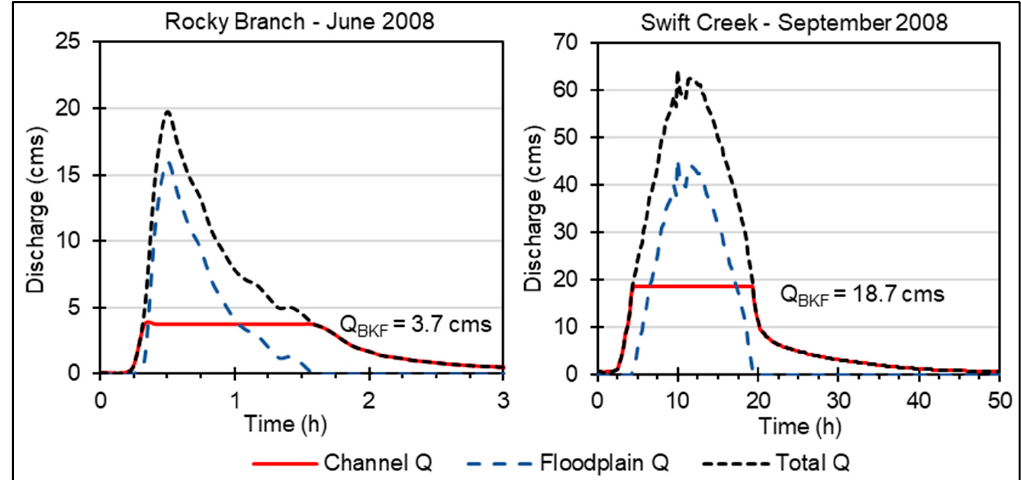
Figure 2. Hydrographs illustrating the flow partitioning approach for storm events at Rocky Branch in June of 2008 and Swift Creek in September 2008.